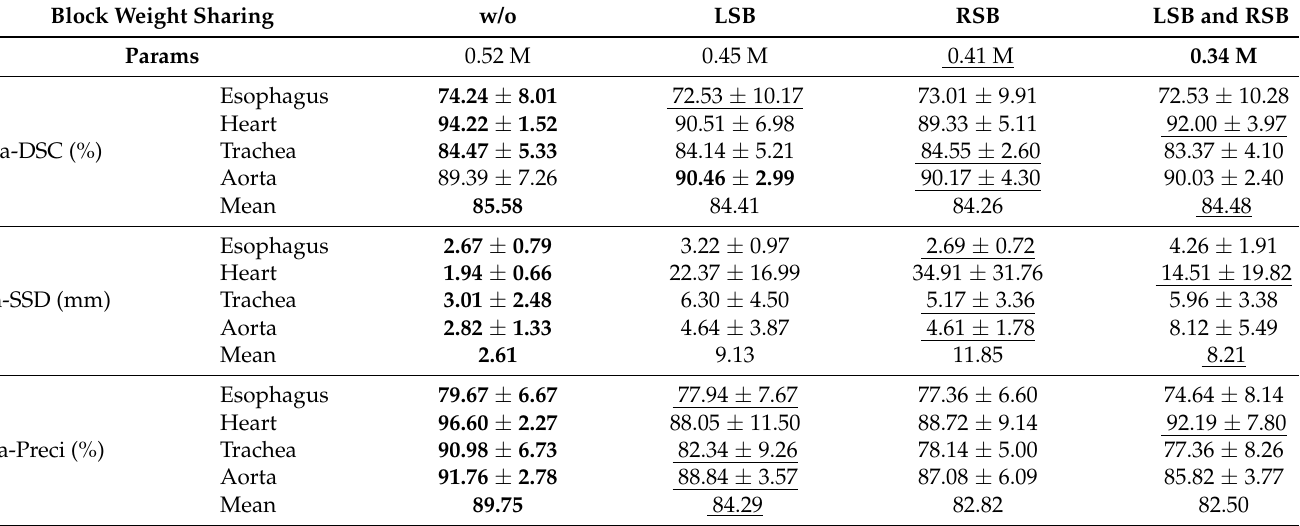
Table 4. Quantitative assessment with the a-DSC, a-SSD, and a-Preci values of using the proposed 2D FAS-UNet framework with/without weight sharing of pre-/post smoothing steps on the 2D SegTHOR validation datasets with four organs: esophagus, heart, trachea, and aorta. “Mean” denotes an average score segmenting all organs. The best and second places are highlighted in bold font and underlined,